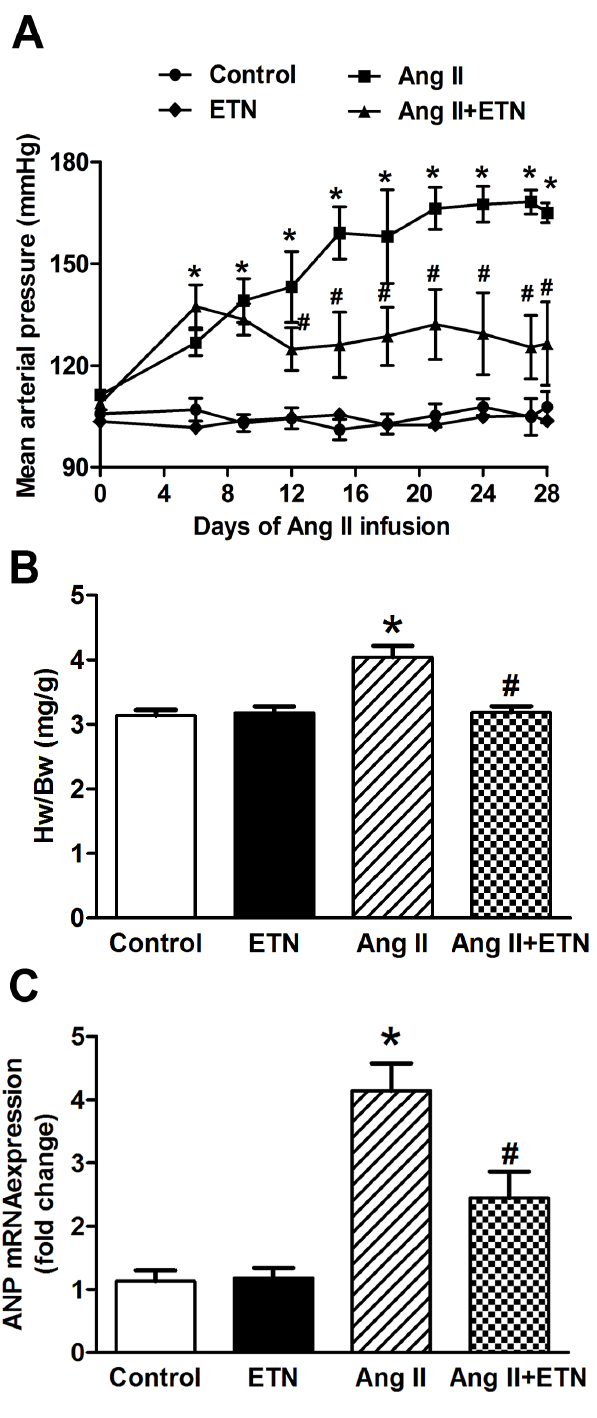
Figure 1. Effect of central TNF blockade on mean arterial pressure (MAP) and cardiac hypertrophy. Ang II infusion for 28 days significantly increased the MAP versus control group, which was attenuated by central blockade of TNF using etanercept ( A ). Chronic Ang II infusion resulted in increased cardiac hypertrophy, as assessed by the ratio of heart weight to body weight (HW/BW) ( B ) and mRNA expression of atrial natriuretic peptide (ANP) in the left ventricular tissue ( C ), which was reduced following central etanercept treatment. n=10– 12 per group, * p , 0.05 vs Control, # p , 0.05 vs Ang II.